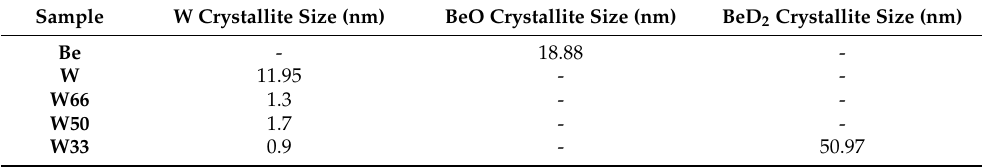
Table 2. Crystallite size calculated for the most intense line in X ray diffraction pattern.